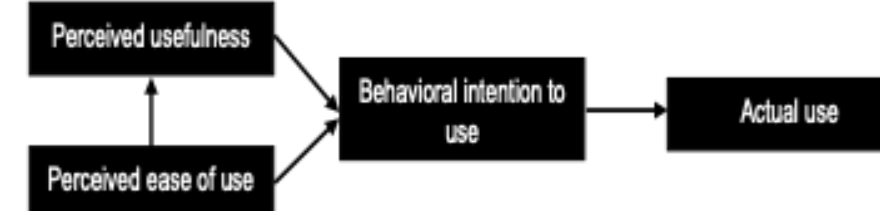
Figure 1. Conceptual Framework based on Technology Acceptance Model